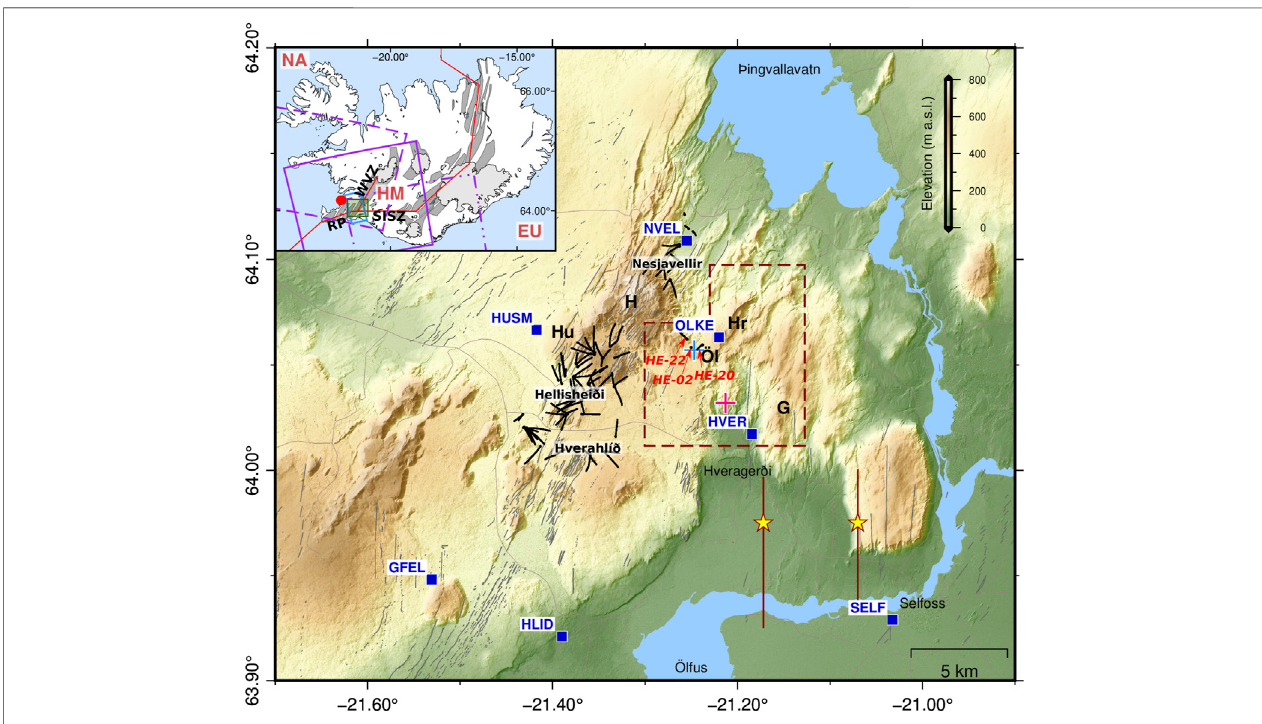
FIGURE 1 | The study area of Hengill with the Hengill (H), Hrómundartindur (Hr) and Grensdalur (G) volcanic systems. Blue squares are the locations of cGNSS stations, red dashed box denotes the area of our seismic analysis. Boreholes trajectories part of the Hellisheiði and Nesjavellir geothermal production fi elds are marked using black lines,including theHúsmúli (Hu)injection area.Three boreholes(HE-02, HE-20and HE-22) ofinterest arehighlightedinthe easternpart ofHengill.Grey lines showfracturesandfaultsofthearea(Cliftonetal.,2002;Einarsson,2008;Hjaltadóttir,2009;Steigerwaldetal.,2020).Yellowstarsshowtwo ∼ M w 6earthquakesin 2008(Decriemetal.,2010).Bluecrossindicatesthecentreof2006 – 2017subsidence(Juncuetal.,2017)inthevicinityoftheÖlkelduhálsridge(Öl)andpinkindicatesthe centreof1993 – 1999upliftepisode(Feigl etal.,2000).Inset:Thegreenboxshows thelocationoftheHengillarea, closetothecapitalcityofReykjavík(reddot).Theblue and purple boxes highlight the outlines of InSAR tracks -T41 from TSX (blue) and three sub-swaths from Sentinel-1 (purple, T16 – solid line, T118 – dash and dots, T155 – dash line). Dark grey areas mark the fi ssures swarms (Einarsson, 2008), and red lines indicate the plate boundary model (Árnadóttir et al., 2009). The North- American plate, Hreppar micro-plate and European plate are denoted by NA, HM and EU, respectively. Hengill is at the junction of Western Volcanic Zone (WVZ), Reykjanes Peninsula (RP) and South Iceland Seismic Zone (SISZ). The Digital Elevation Model used is the ArcticDEM (Porter et al., 2018, modi fi ed by the National LandSurvey of Iceland,